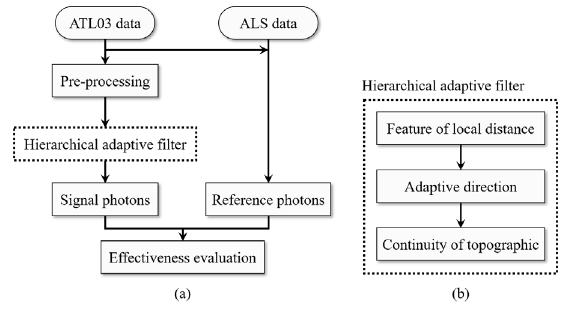
Figure 2 . The workflow of this